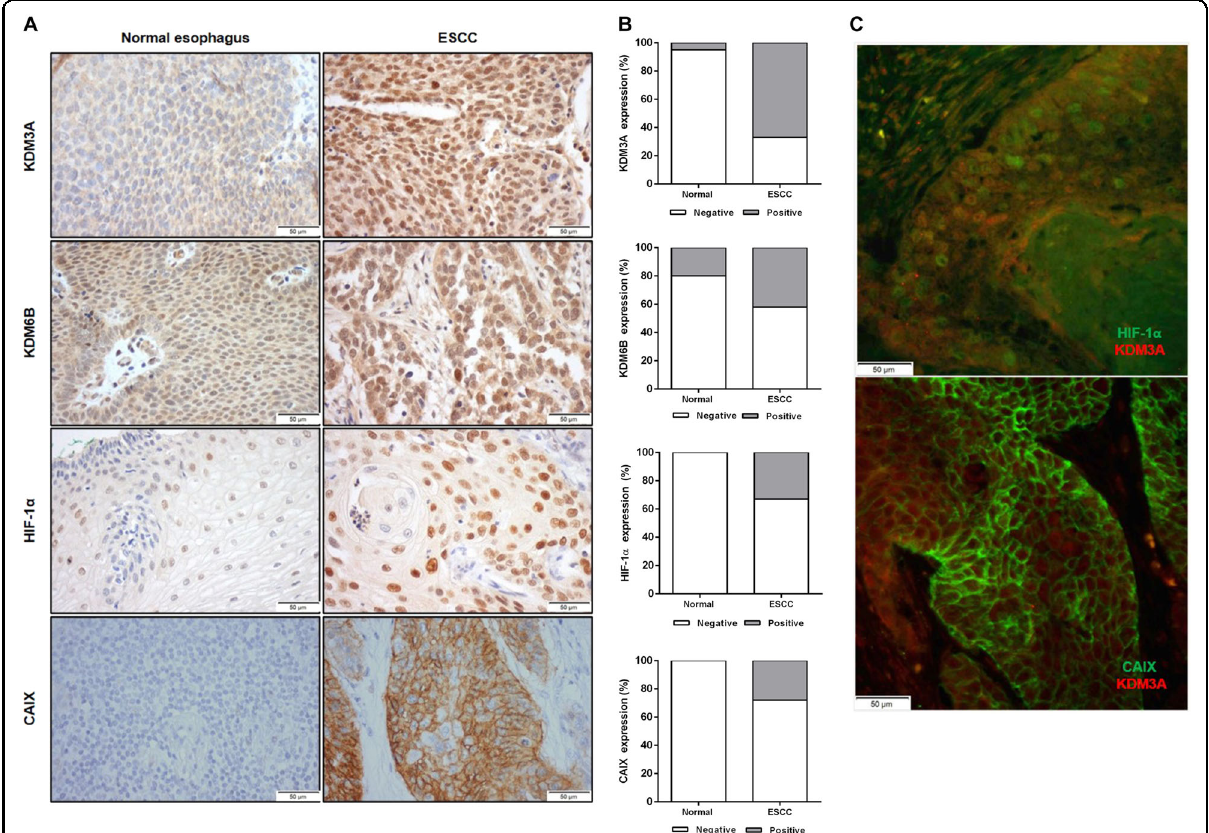
Fig. 7 JmjC-KDMs expression in ESCC and normal esophagus tissue samples. a Representative IHC images for KDM3A, KDM6B, HIF-1 α , and CAIX expression in NE and ESCC tissues. Pictures were taken from a microscope Olympus BX41 with a digital camera Olympus U-TV0.63XC, at ×200 magni fi cation (scale bar 50 μ m). b Graphical representation of % protein expression in ESCC and NE. c IF co-localization of KDM3A (red fl uorescence) and HIF-1 α and CAIX (green fl uorescence) in ESCC tissue. Representative pictures were taken from Olympus IX51 microscope at ×200 magni fi cation (scale bar 50 μ m).